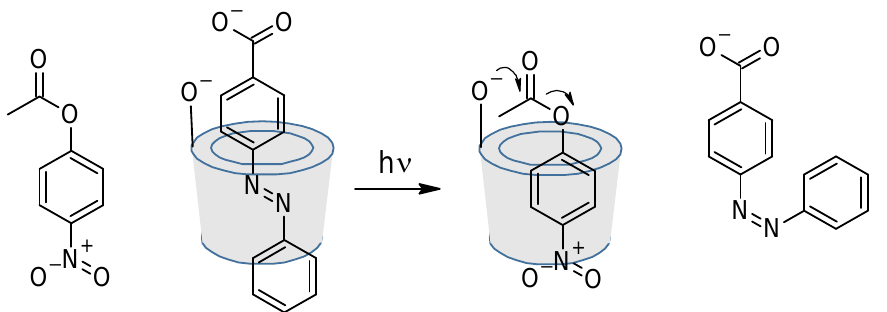
Figure 17. Excluding photochromic inhibitor.